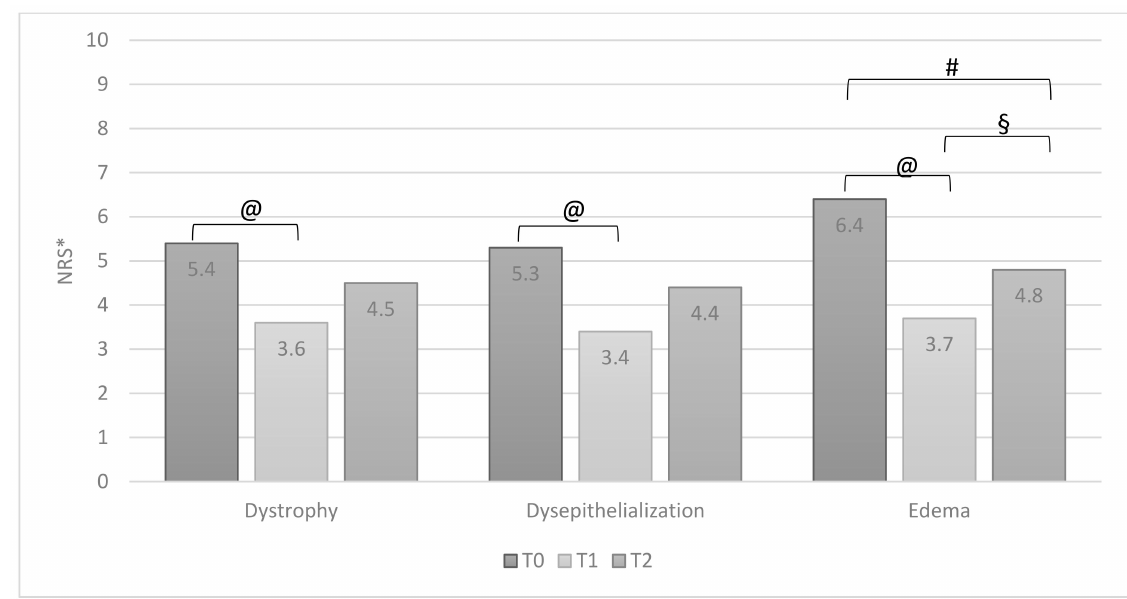
Figure 6. Group B: patients’ signs of inflammation T0, T1 and T2 (ANOVA test, values are means). * NRS: Numeric Rating Scale, 10-point scale. @ p = 0.0001; # p = 0.001; § p = 0.023.